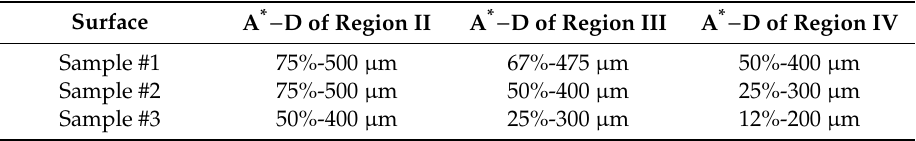
Table 2. Summarized properties of fabricated surfaces.